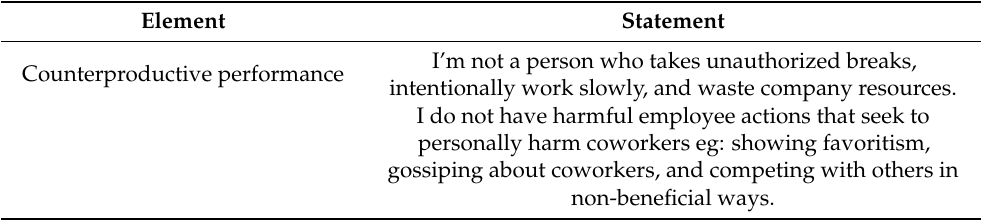
Table 5. Elements and statements of the dimension called counterproductive